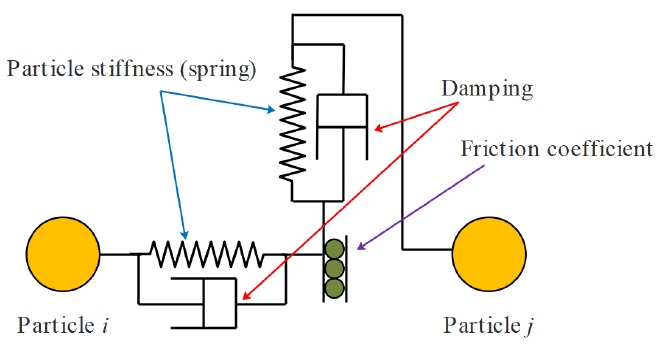
Figure 4. The Hertz–Mindlin contact model.